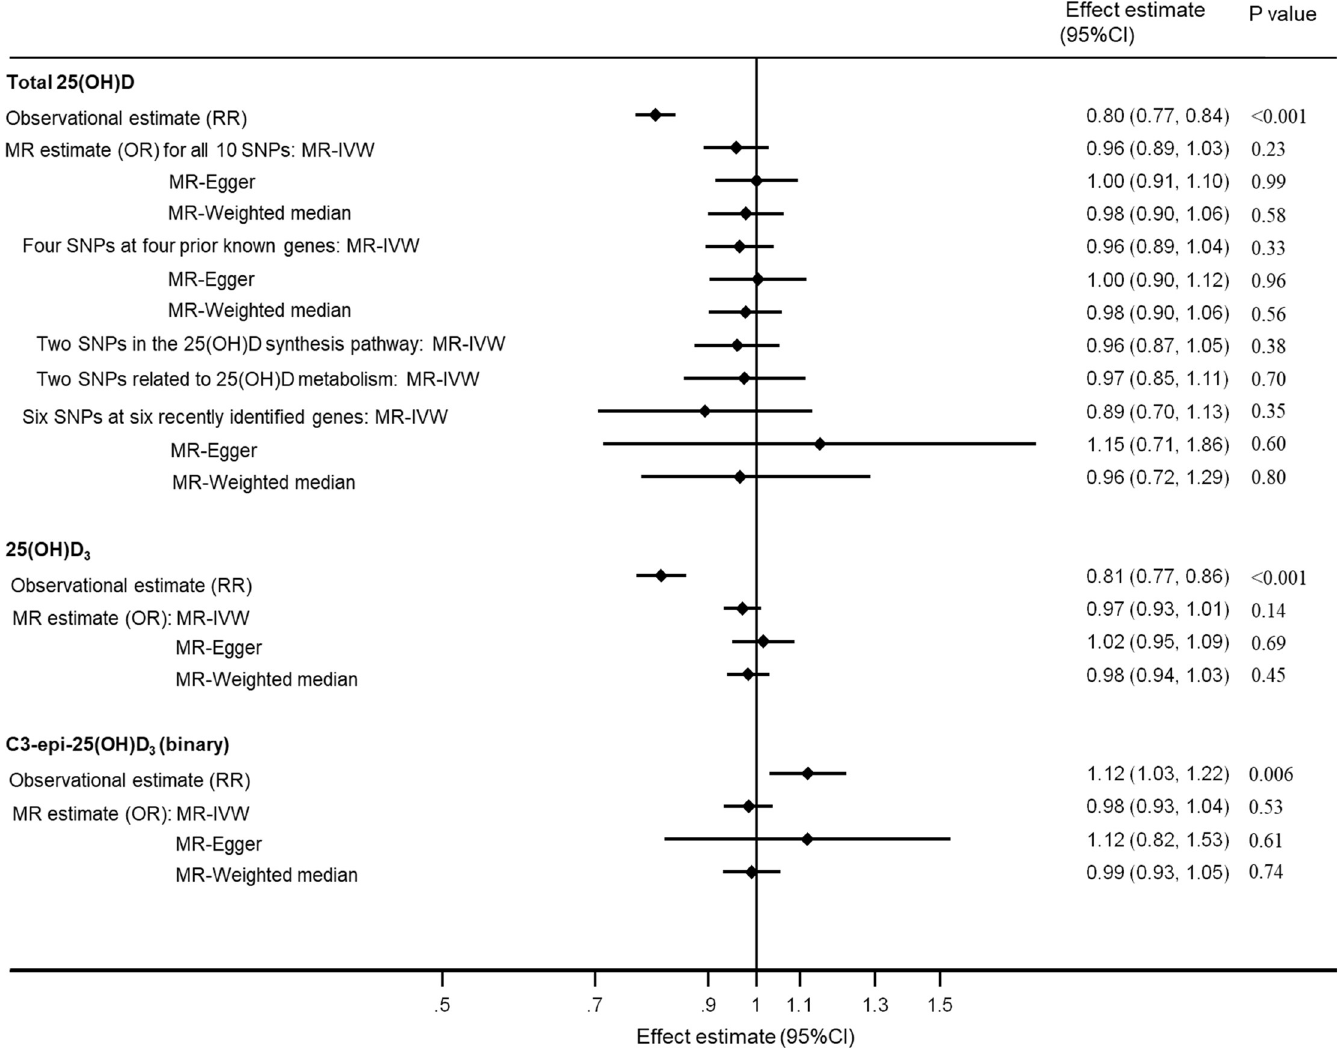
Fig 3. Association of 25(OH)D metabolites with type 2 diabetes from observational and MR analyses. Estimates (95% CIs) were scaled to represent RRs from observational analyses or ORs from MR per 1–standard deviation difference in each 25(OH)D metabolite, except for the binary C3-epi-25(OH)D 3 variable (above versus below the lower limit of quantification). For the MR sensitivity analysis for total 25(OH)D, the 4 prior known genes are GC , CYP2R1 , NADSYN1/DHCR7 , and CYP24A1 ; the 25(OH)D synthesis pathway genes are CYP2R1 and NADSYN1/DHCR7 ; the 25(OH)D metabolism genes are GC and CYP24A1 ; and the 6 recently identified genes are PADI1 , CRCT1 , UGT1A5 , AMDHD1 , SEC23A , and SULT2A1 . For each analysis, 3 MR methods were used, including the IVW method, MR-Egger method, and weighted median method. For MR analyses based on 2 SNPs, the MR-Egger and weighted median methods could not be applied. For the observational estimate, the total number of type 2 diabetes cases and non-cases was 15,611 and 21,106, respectively, for total 25(OH)D, and 8,331 and 11,837, respectively, for 25(OH) D 3 (or C3-epi-25(OH)D 3 ). For the MR estimate of all 3 vitamin D variables, the total number of cases and non-cases was 80,983 and 842,909, respectively. 25(OH)D, 25-hydroxyvitamin D; CI, confidence interval; IVW, inverse-variance-weighted; MR, Mendelian randomisation; OR, odds ratio; RR, relative risk; SNP, single nucleotide